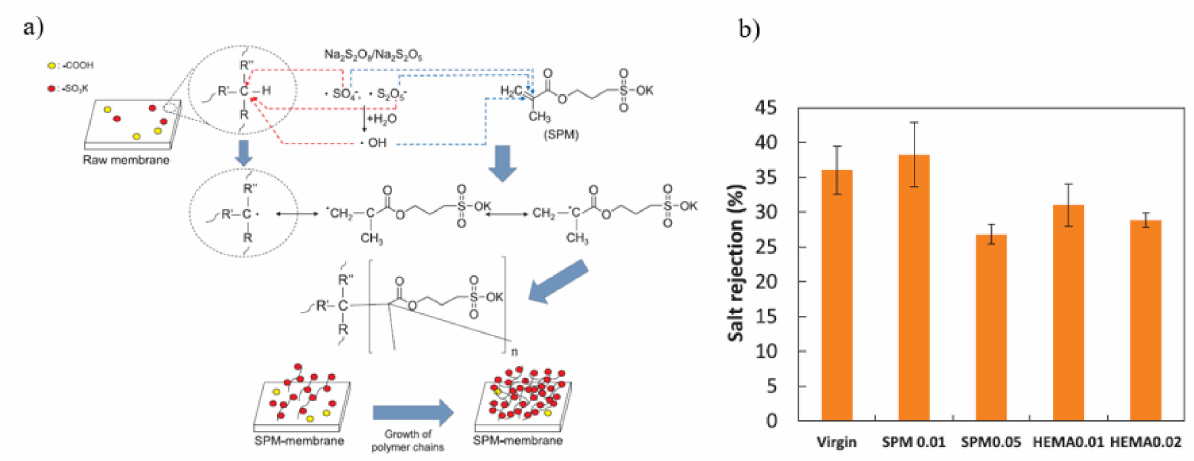
Figure 9. ( a ) Scheme of radical graft polymerization using 3-sulfopropyl methacrylate potassium salt (SPM) for membrane surface modification; ( b ) Salt rejection of pristine and SPM, hydroxyethyl methacrylate (HEMA) modified membrane with different concentrations [137]. Error bars represent one standard deviation of triplicate